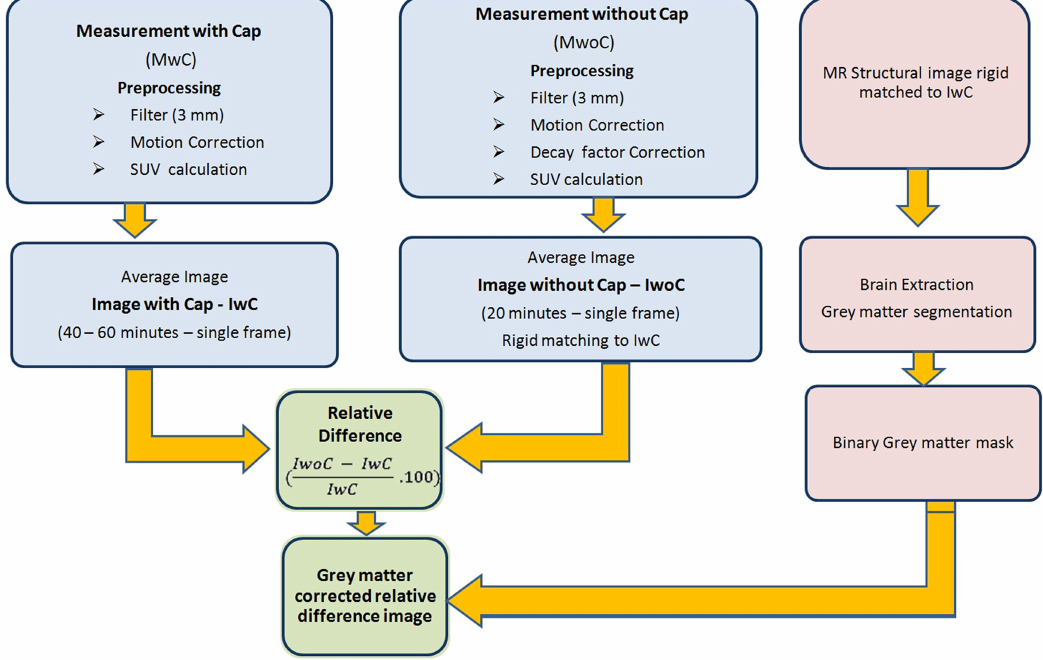
Fig 2. Flow chart showing preprocessing steps for FDG PET human